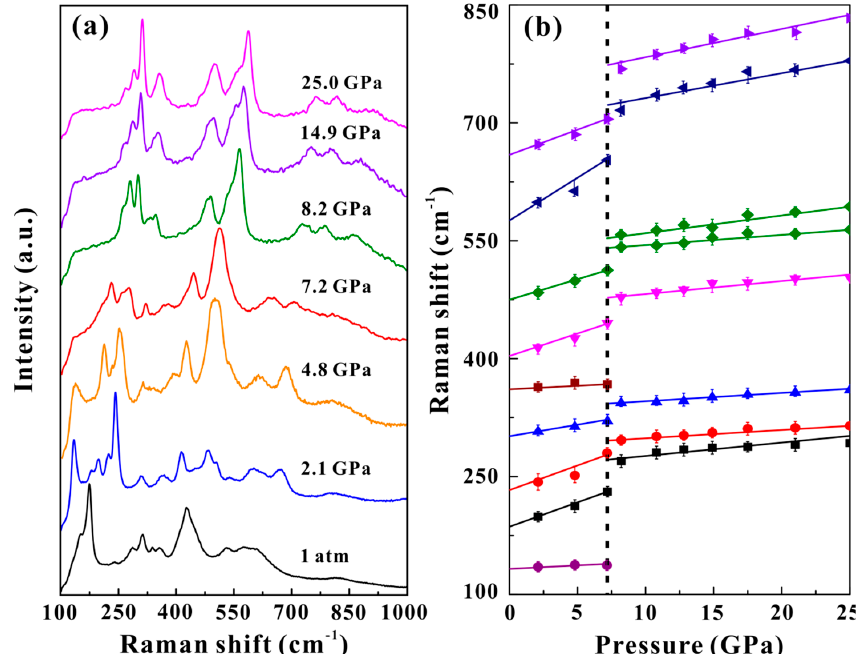
Figure 3. ( a ) Raman spectra of nanocrystalline rutile at selected pressures in the process